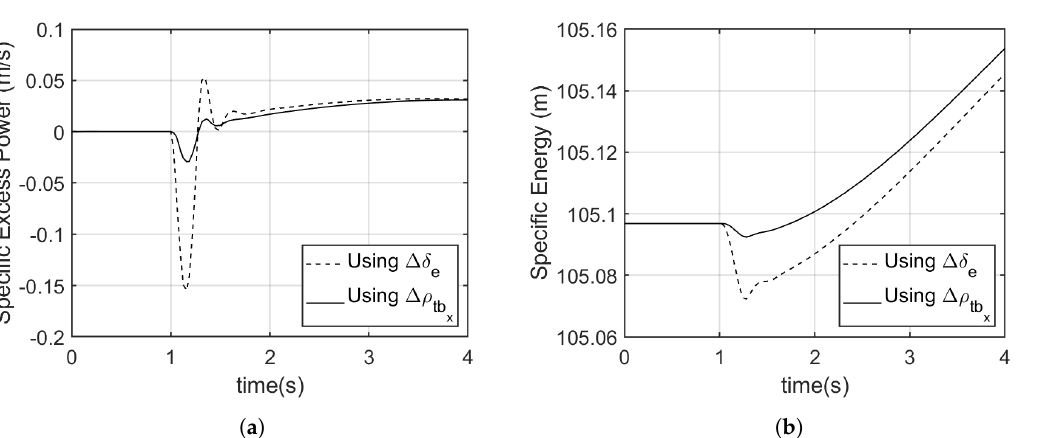
Figure 11. Model 1 aircraft pull up maneuver time response. ( a ) Specific excess power. ( b ) Specific energy.